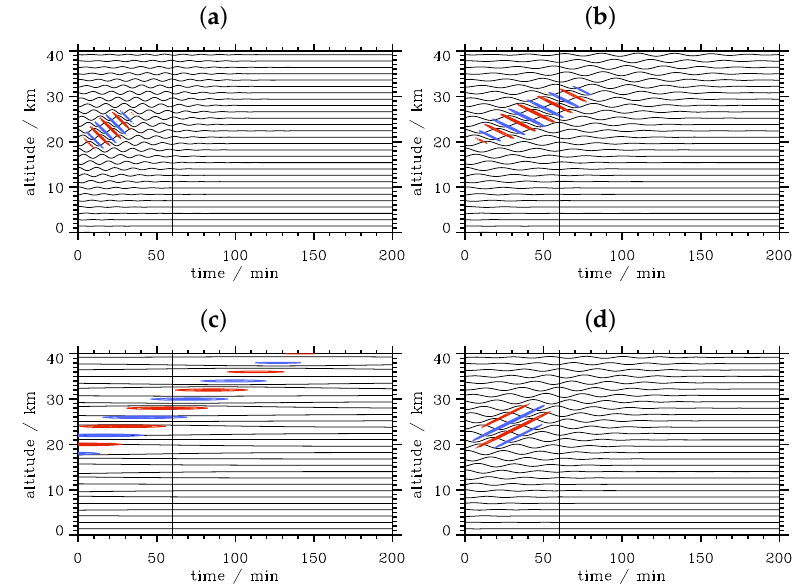
Figure 8. Vertical time series of the vertical displacements ξ ( x , z , t ) of horizontally- and vertically-propagating wave packets with the wavenumber vector (cid:126) k D recorded at the horizontal positions marked in Figure 7. The wave frequencies are Doppler shifted by U = + c Px ( a ), U = 0 ( b ), U = − c Px ( c ) and U = − 2 c Px ( d ), respectively. Red and blue contour lines refer to ± 0.95 times the wave amplitude and illustrate phase lines. The vertical black lines refer to the time t = 60min where the altitude-distance plots are shown in Figure